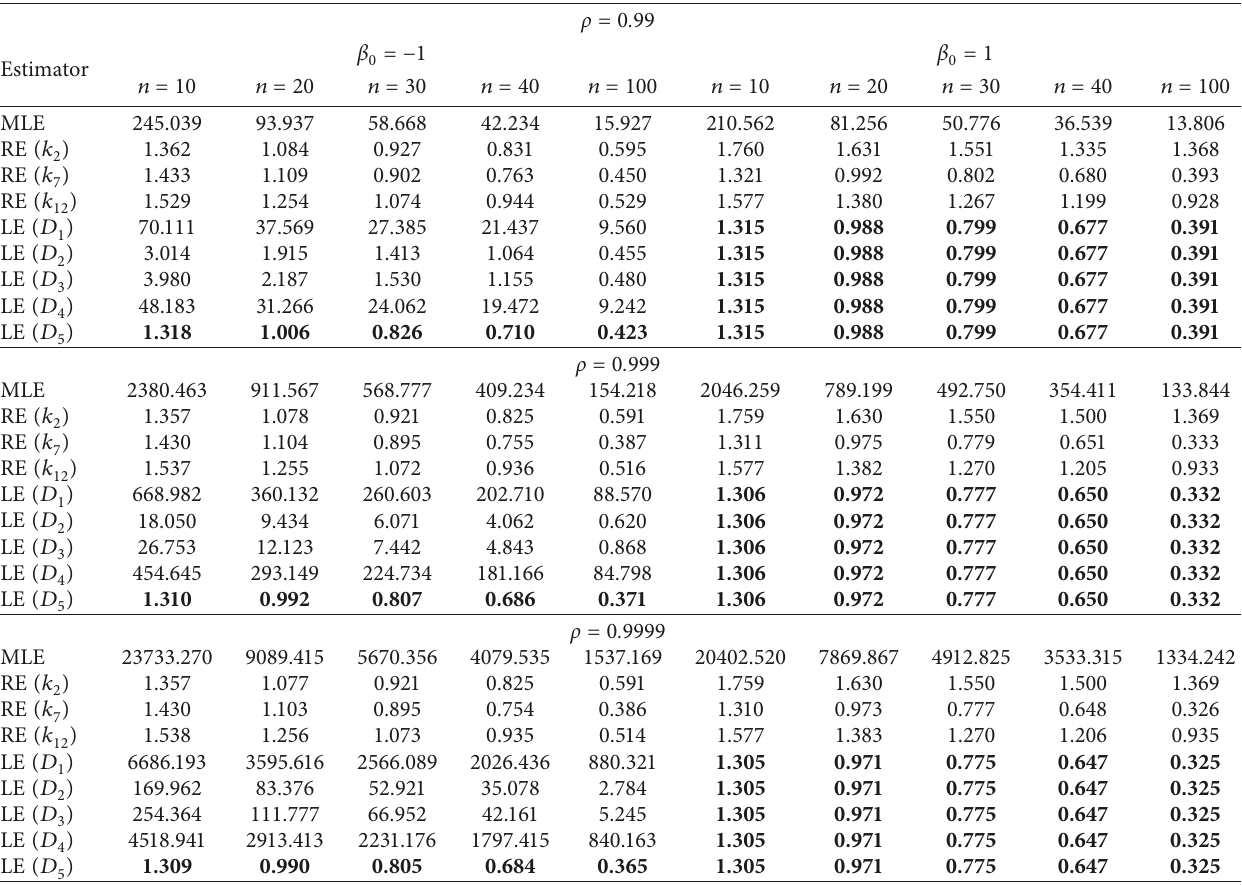
Table 4: Estimated SMSE values for different n, ρ ,k, d, and β